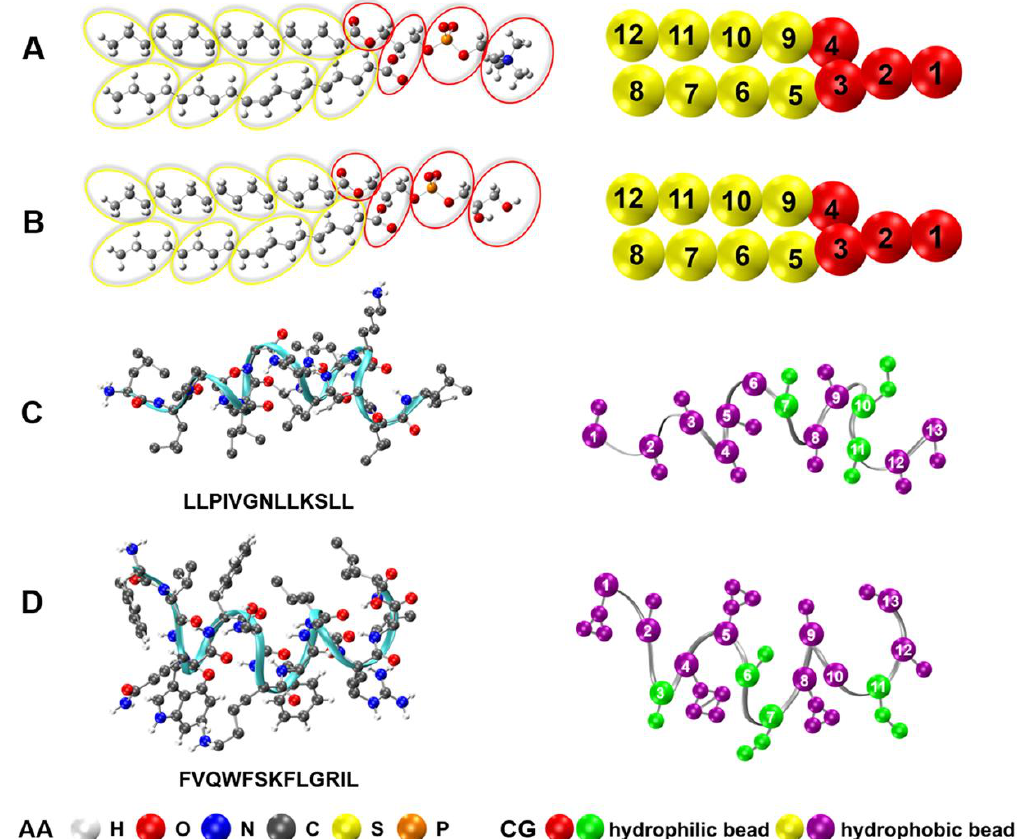
Figure 1. Schematic illustration of molecular structures of ( A ) POPC, ( B ) POPG, ( C ) temporin B and ( D ) temporin L, and their corresponding coarse-grained mappings. For POPC and POPG, the CG hydrophilic head beads are in red and the hydrophobic tail beads are in yellow. For TB and TL, the hydrophilic residues are in green and the hydrophobic residue beads are in purple.